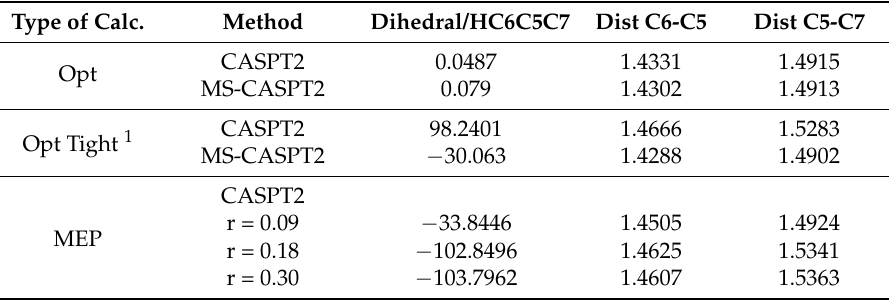
Table 3. Geometrical parameters describing the structures obtained with different geometry optimization and MEP procedures at the CASPT2(10,8)/6-31G* level of theory. Distances are given in Å and angles in degrees. Type of